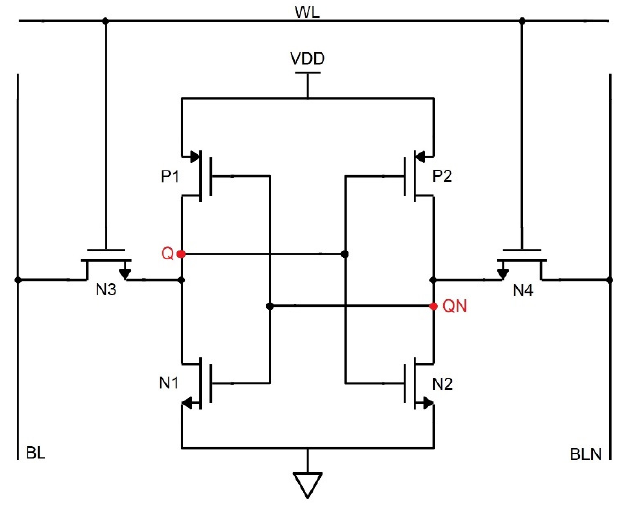
Figure 4. Schematic of the 6T SRAM configuration.